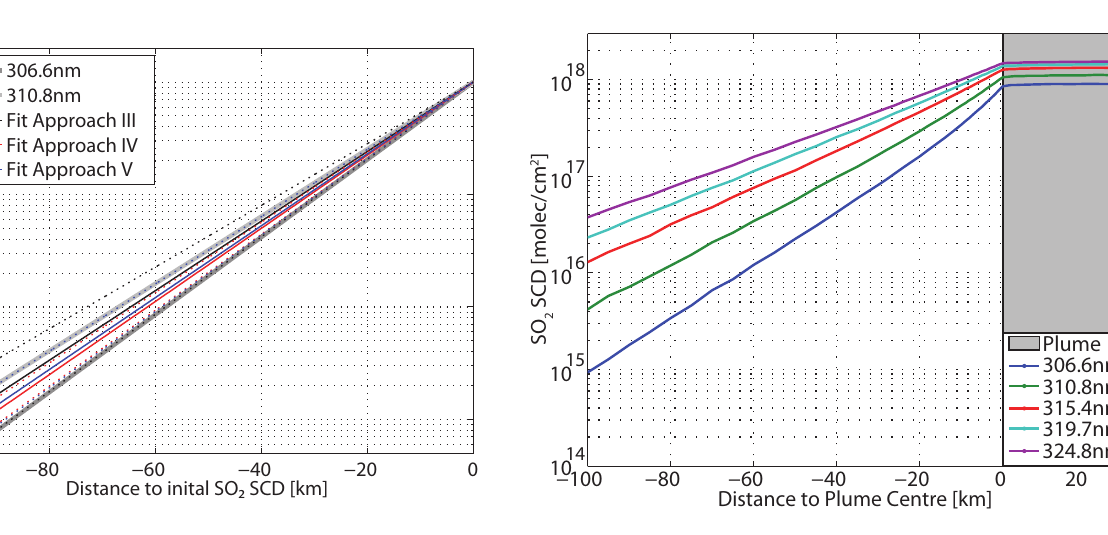
Fig. 12. Relative changes of SO 2 SCDs for approaches III–V and comparison to the mean extinction coefficients derived by model runs A1–A3. The dashed lines indicate the 95% confidence interval.